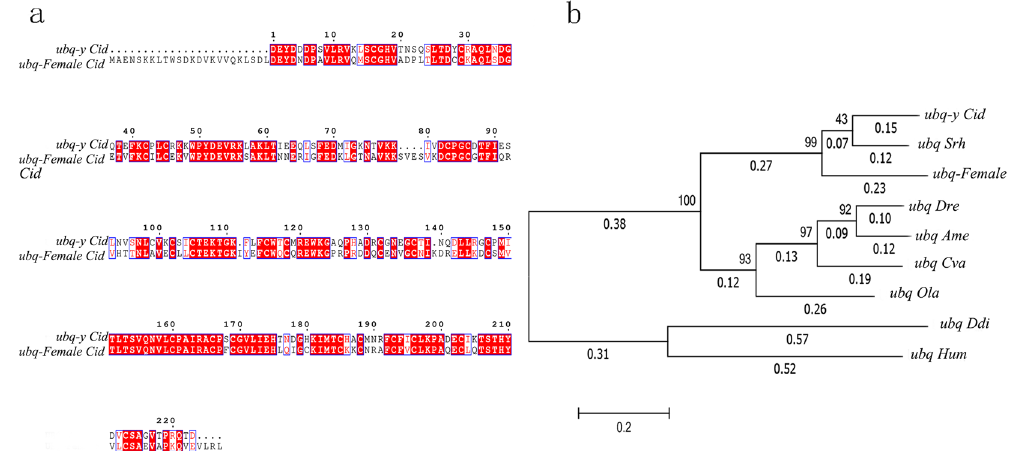
Figure 7. Phylogenetic analysis of ubq genes and alignment of grass carp ubq-y gene with its female homolog. ( a ) Alignment of coding protein sequences between ubq-y gene and its female homolog in grass carp. Sequences were aligned with ClustalW2. The result showed widespread differences in amino acid sites, suggesting that ubq-y gene is a divergent paralog (amino acid identity of 75%). ( b ) Phylogenetic analysis of ubq genes. A Maximum Likelihood tree with Poisson correction was constructed using MEGA6 46 . Bootstrap support values (10,000 replicates) are shown inside the tree. The tree is drawn to scale, with branch lengths measured using the number of substitutions per site (below the branches). All positions with gaps and missing data have been eliminated. Sequence accession numbers are shown in Supplementary Table S7. Phylogenetic analyses of ubq genes suggested that ubq-y gene diverged from the female homologous gene in certain fish species. Species information are: Sinocyclocheilus rhinocerous (Srh); Astyanax mexicanus (Ame); Cyprinodon variegatus (Cva); Oryzias latipes (Ola); Dictyostelium discoideum (Ddi); Homo sapiens (Hum); Danio rerio (Dre)